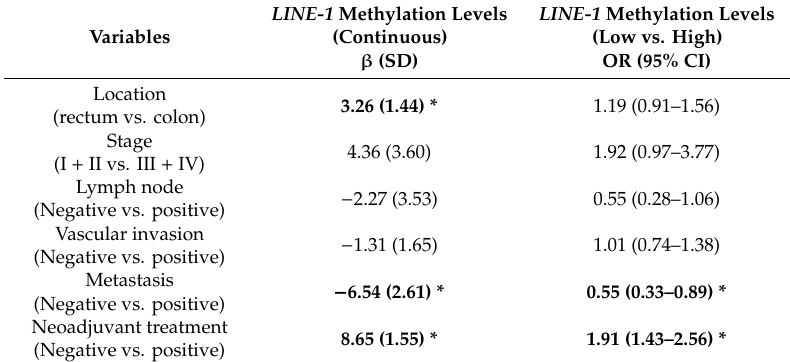
Table 3. The association between LINE-1 methylation status and clinicopathological